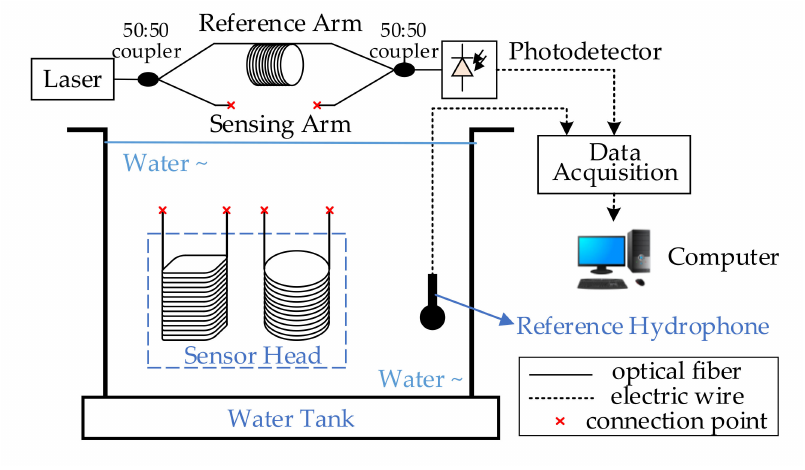
Figure 8. Measurement